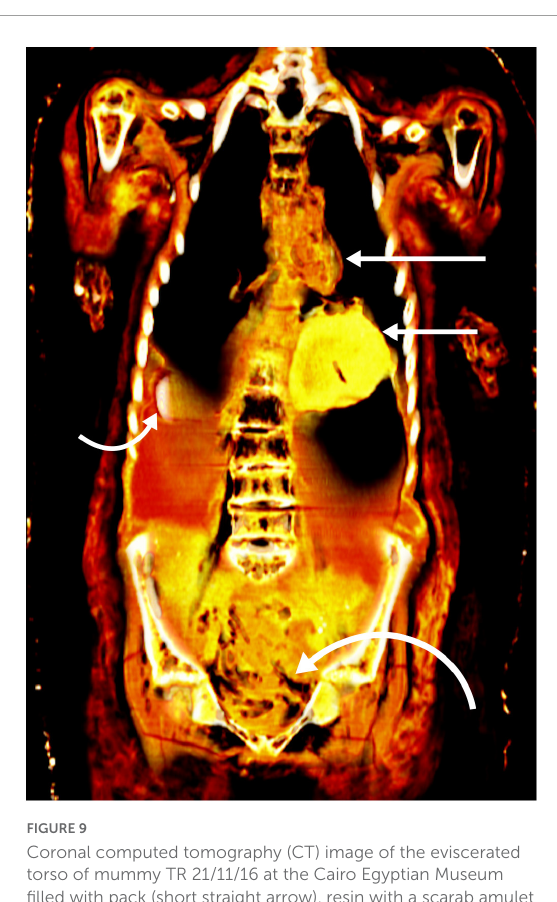
FIGURE9 Coronal computed tomography (CT) image of the eviscerated torso of mummy TR 21/11/16 at the Cairo Egyptian Museum filled with pack (short straight arrow), resin with a scarab amulet partially embedded in it (short curved arrow), and loose linen (long curved arrow). Note that the heart was not removed during the mummification (long straight arrow).